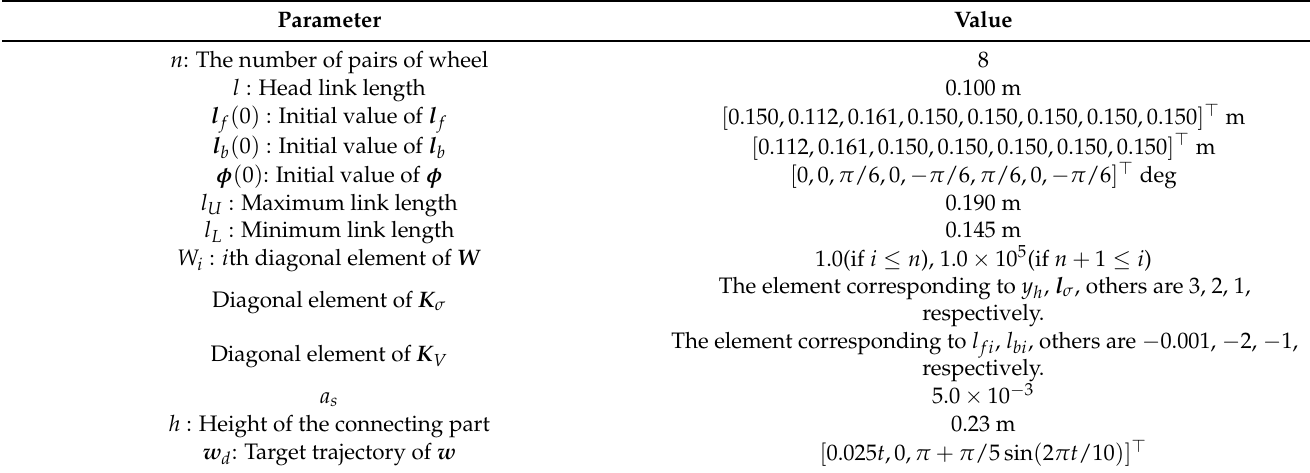
Table 1. Parameters of